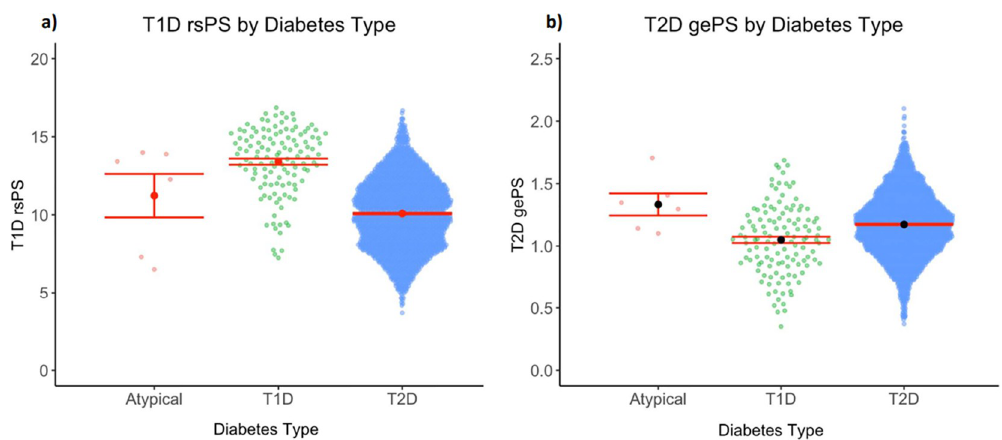
Fig 3. Polygenic scores compared between individuals in the AD, ML T1D, and ML T2D cohorts: (a) T1D rsPS, and (b) T2D gePS. (a) Restricted to significant polygenic score (rsPS) for T1D did not differ significantly between the atypical diabetes (AD), machine learning (ML) type 1 diabetes (T1D), and ML type 2 diabetes (T2D) cohorts. (b) The global extended polygenic score (gePS) for T2D was significantly higher in the AD group in comparison to the ML T1D cohort.